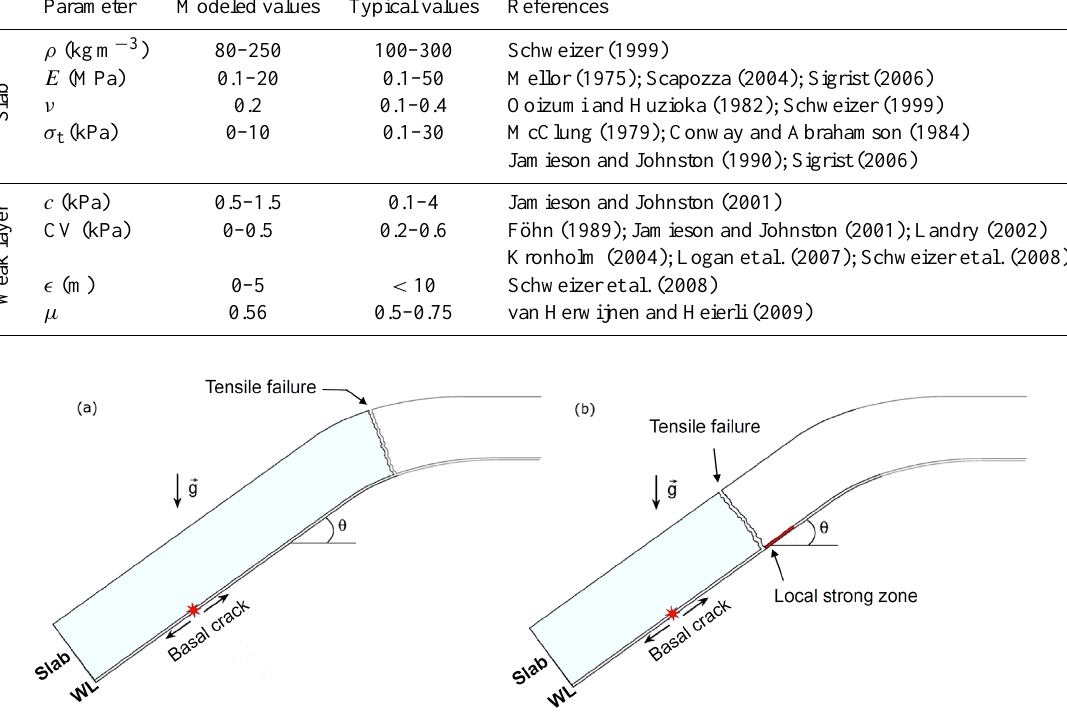
Figure 1. Schematic representing the two types of failure observed in the simulations. (a) Full-slope release: the crack in the WL propagates across the whole slope. The position of the slab tensile failure would then depend on morphological features (rocks, trees, ridges, curvature, etc.). (b) Partial-slope release: the local heterogeneity is sufficient to stop the propagation of the crack in the WL and thus trigger the tensile failure within the slab. The red-colored part of the weak layer represents a local zone of large shear